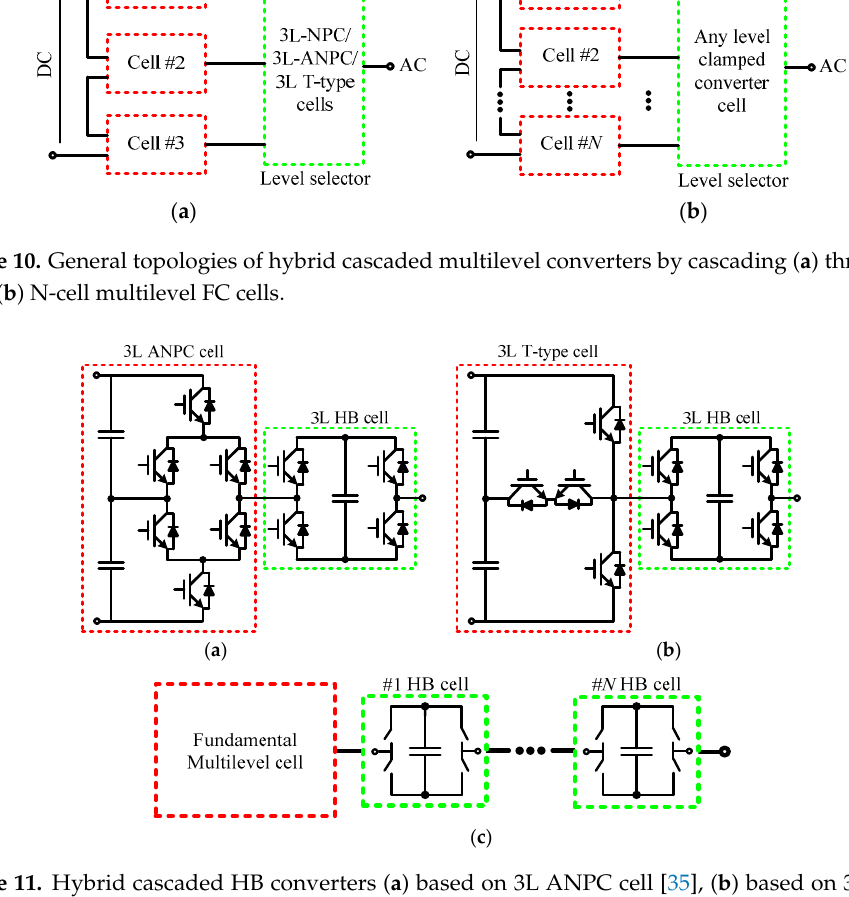
( c ) Figure 11. Hybrid cascaded HB converters ( a ) based on 3L ANPC cell [35], ( b ) based on 3L T ‐ type cell [36], ( c ) general structure with N HB cells. If an m ‐ level fundamental cell id cascaded with N HB cells, the output voltage level can be calculated by: